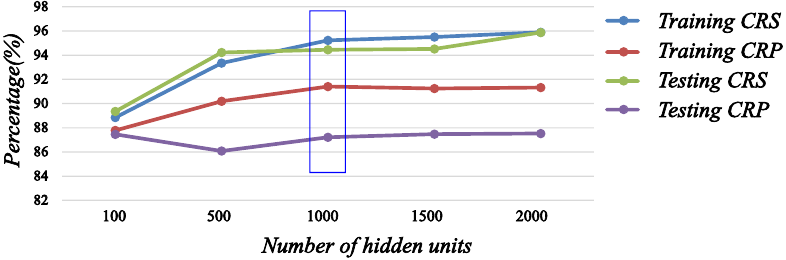
Figure 13. The CRS and CRP of the gait phase recognition model for different numbers of hidden